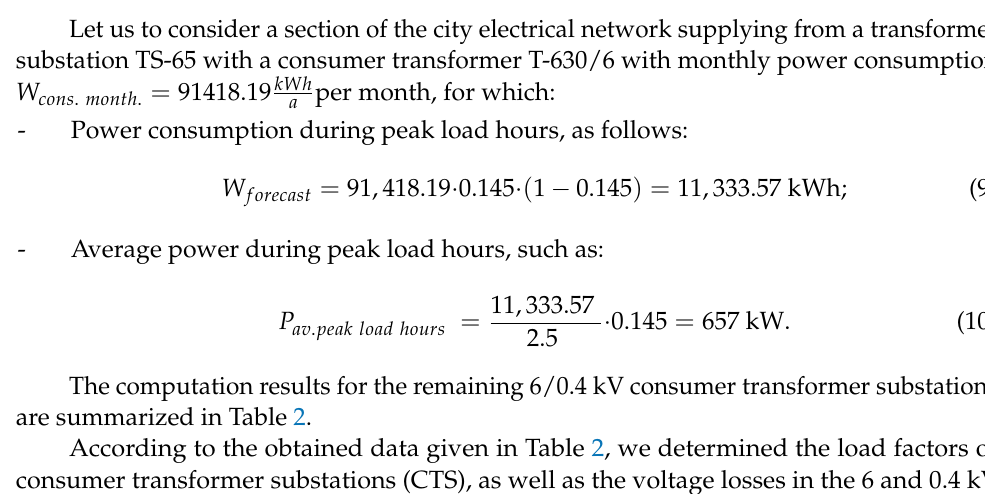
Table 2. Computation results of power consumption and average power during the hours of maxi- mum loads.